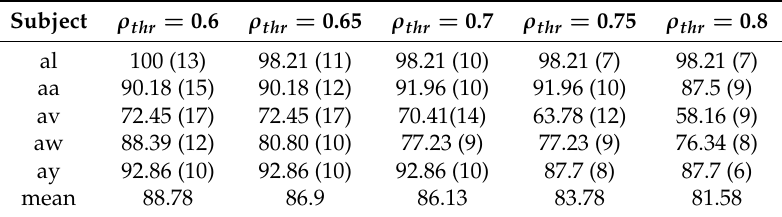
Table 4. Threshold and classification performance of the proposed method for 18 channels ( K = 18) BCI Competition III Dataset IVa.